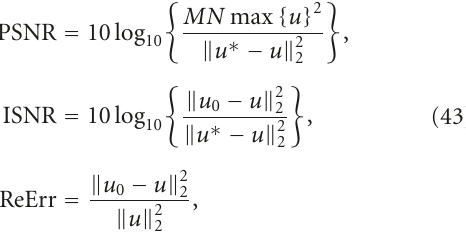
Figure 1: (a) The original “Lena” image; (b) the synthetic image “SynImag”; (c) the SAR image.